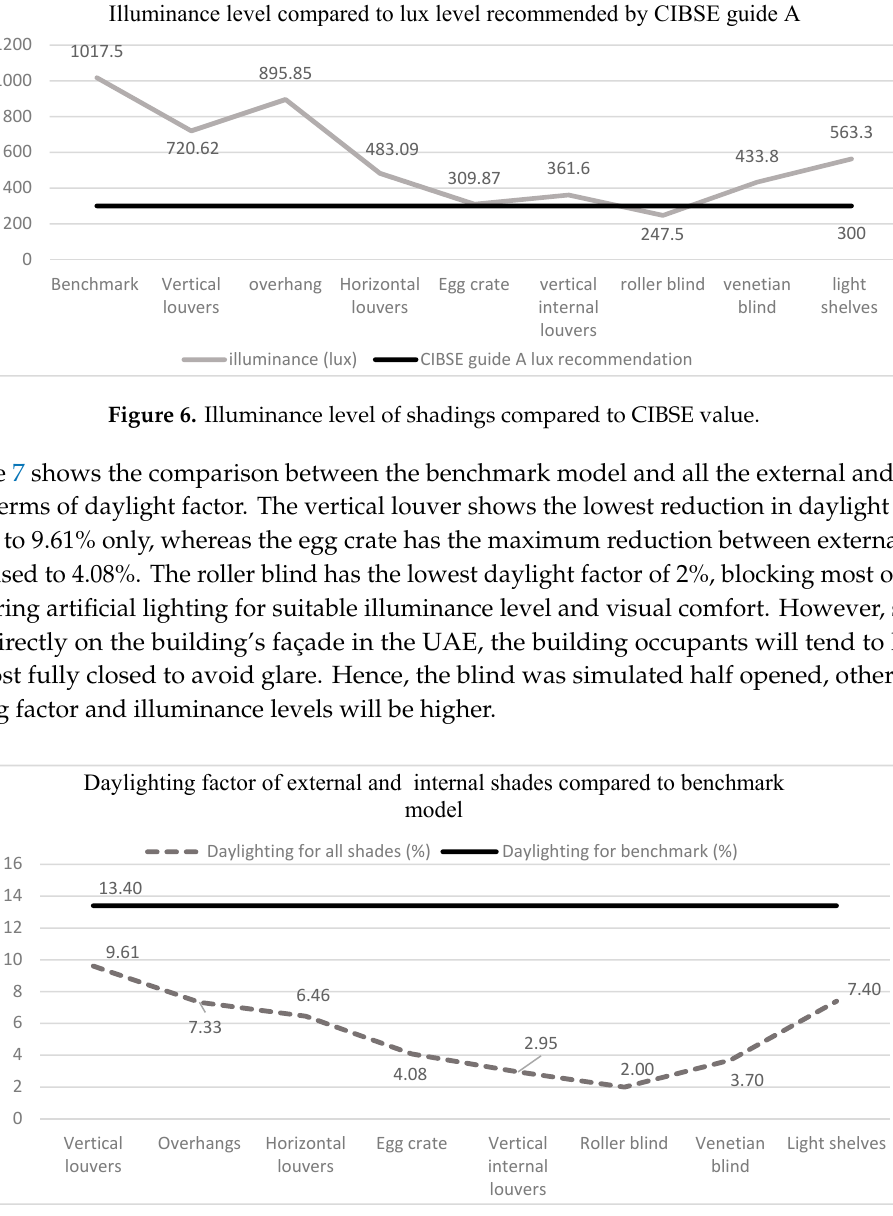
Figure 7. Comparison between benchmark and external and internal shades for daylighting factor Figure7. Comparisonbetween benchmarkandexternal andinternal shadesfordaylighting levels.